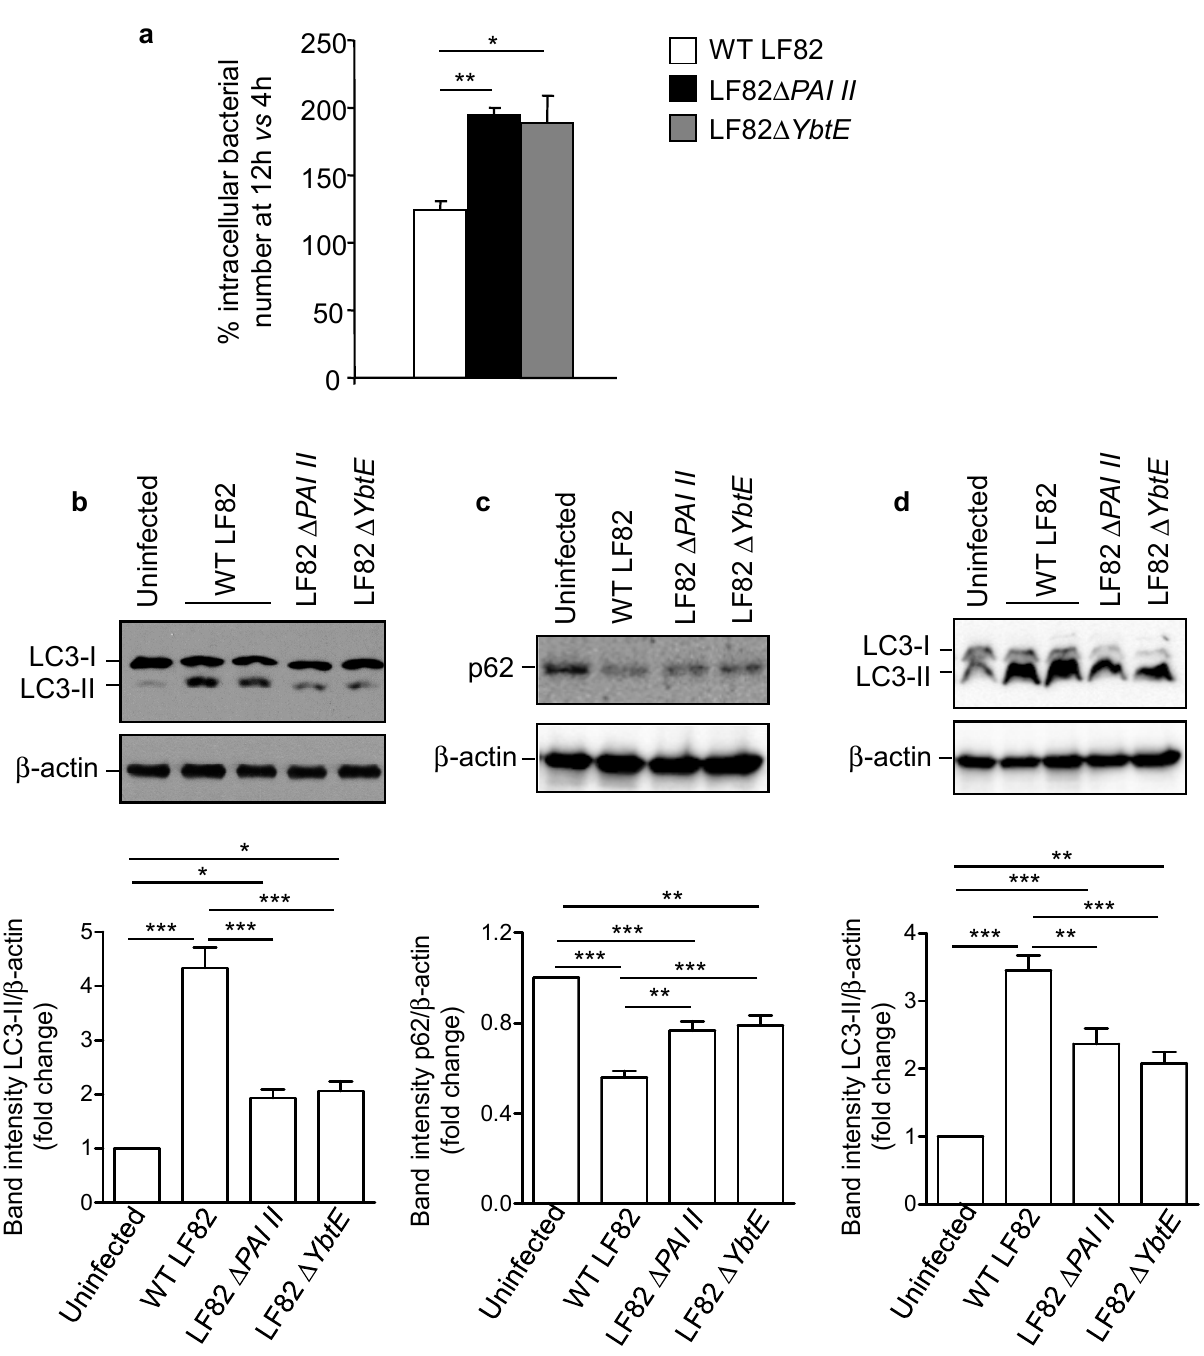
Figure 3. Loss of yersiniabactin decreases autophagy in intestinal epithelial cells (IECs) and increases AIEC LF82 intracellular proliferation. ( a ) T84 cells were infected with either the wild-type (WT) LF82 strain or one of the mutants AIEC ∆ PAI II and AIEC ∆ YbtE for 3 h, washed, and incubated with gentamicin for 1 h or 9 h. The number of intracellular bacteria was counted on LB agar plates and is presented as the percentage of intracellular bacteria at 12 h (3 h infection + 9 h in gentamicin) compared to 4 h (3 h infection + 1 h in gentamicin) post-infection. Data are means ± SEM of six replicates and are representative of two independent experiments. ( b , c ) T84 cells were infected with WT LF82, LF82 ∆ PAI II , or LF82 ∆ YbtE strain for 3 h, washed, and incubated with gentamicin for 3 h. Expression of LC3 and p62 was analyzed by Western blot. Bar graphs represent the quantification of bands’ intensity from immunoblots. ( d ) Cells were pre-treated with bafilomycin A1 at 50 nM for 30 min and then infected as in b and c in cell culture medium containing 50 nM of bafilomycin A1. ( b – d ) Data are means ± SEM of three replicates and are representative of three independent experiments. ( a – d ) * p < 0.05, ** p ≤ 0.01, *** p ≤ 0.001 by one-way Anova, followed by a post-test Bonferroni.